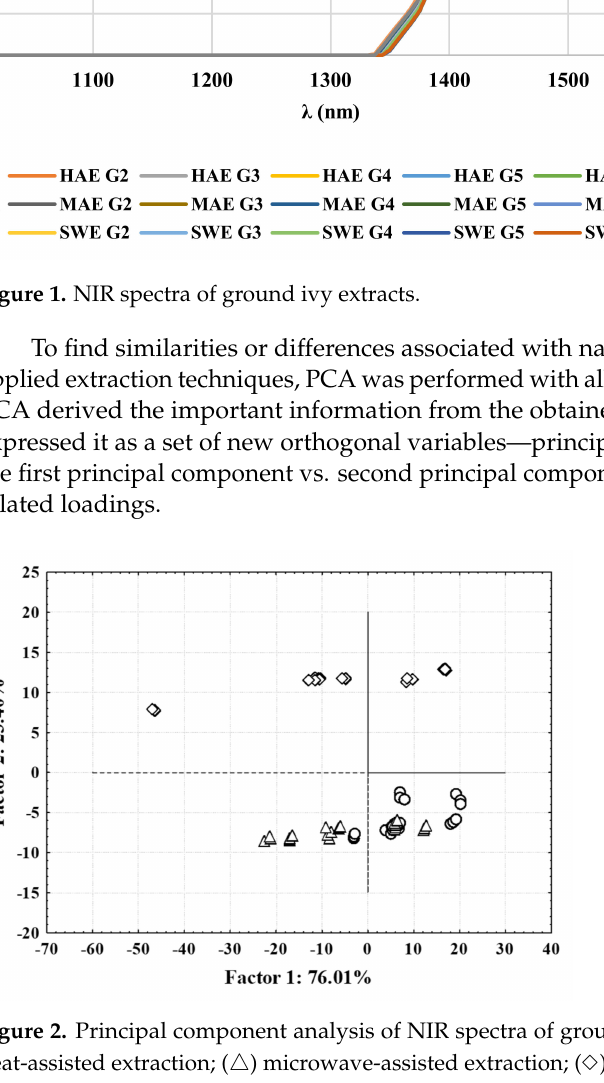
) conventionally (cid:35) ) subcritical water (cid:51)